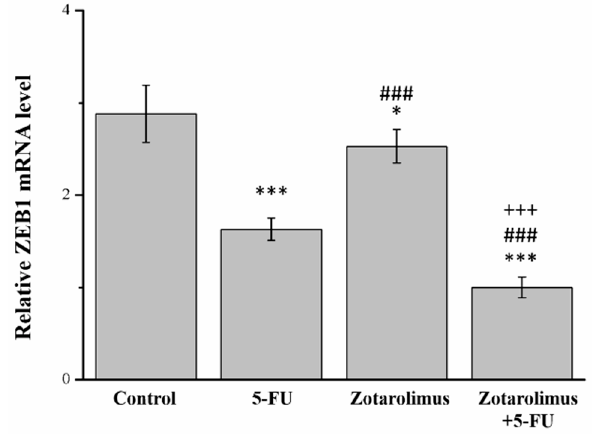
Figure A6. Relative gene mRNA expression of ZEB1 using quantitative PCR. All experiments were conducted on the A549 tumor masses from BALB/cByJNarl mice given different treatments, including control, 5-FU (100 mg/kg/week), zotarolimus (2 mg/kg/day), and zotarolimus (2 mg/kg/day) combined with 5-FU (100 mg/kg/week). All data are presented as mean ± standard deviation, n = 7 per group. * p < 0.05 and *** p < 0.001 compared with the control group. ### p < 0.001 compared with the 5-FU-treated group. +++ p < 0.001 compared with the zotarolimus-treated group.